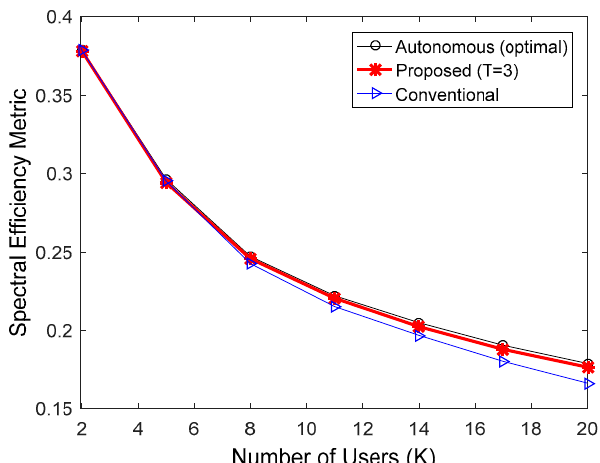
Figure 6. Comparison of spectral efficiency in the IEEE 802.16e downlink when the MCS level was fixed at 4.